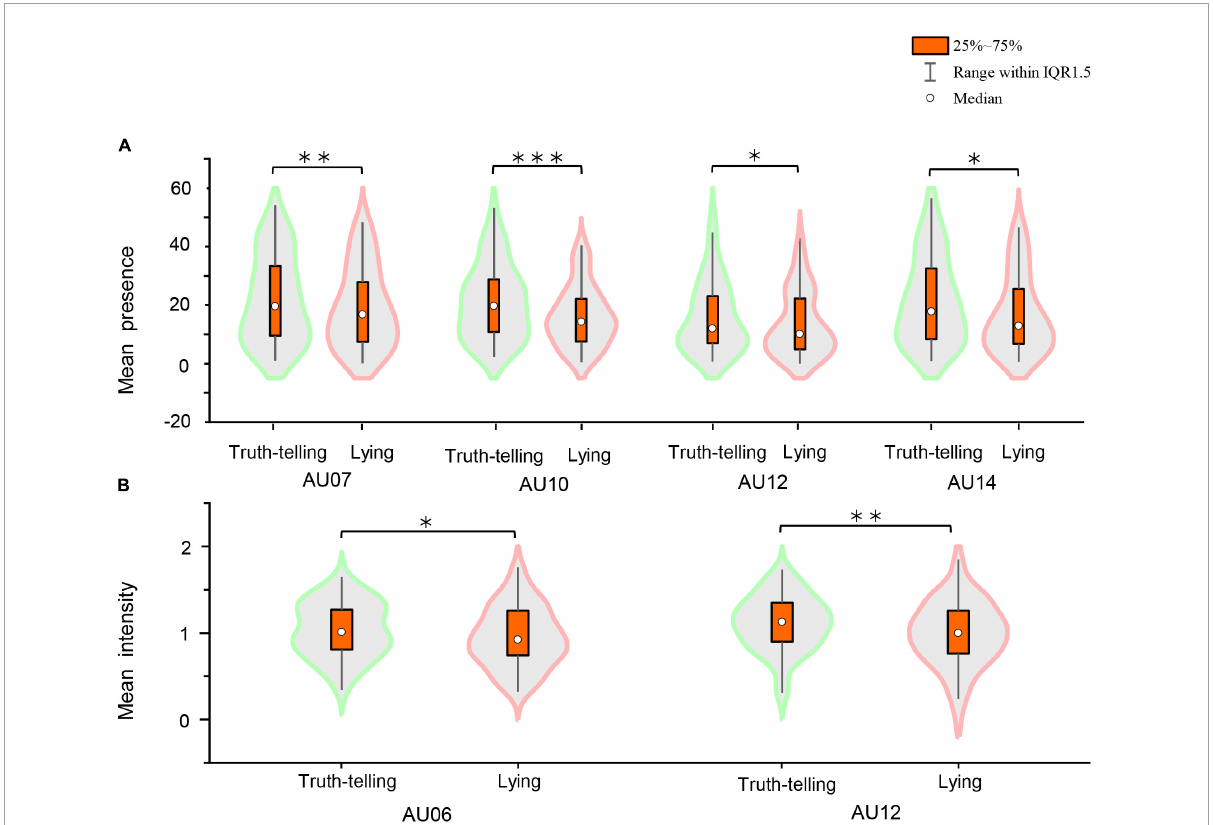
FIGURE4 (A) Mean presence. (B) Mean intensity. Statistically significant differences between lying and truth-telling: ∗ p < 0.05, ∗∗ p < 0.01, and ∗∗∗ p <